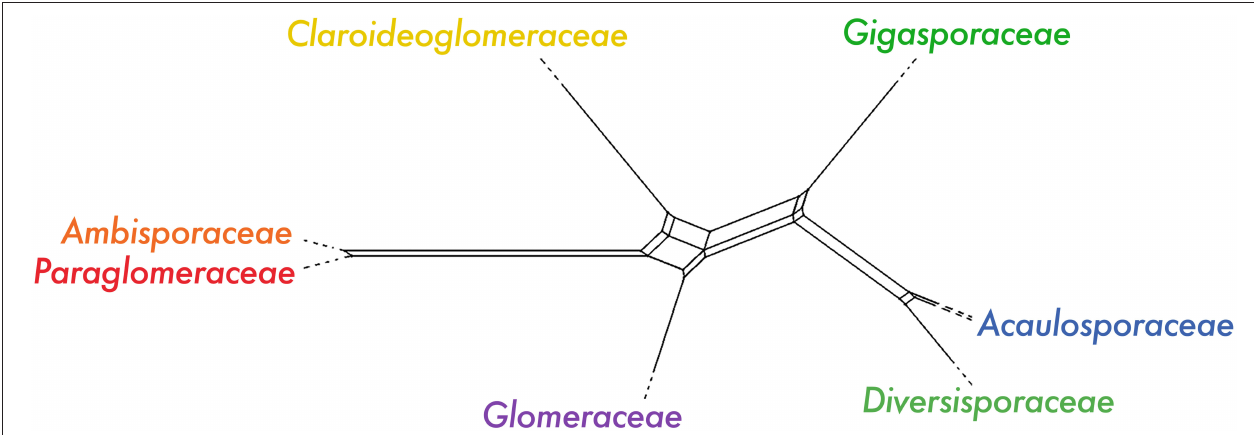
FIGURE 3 | IQ-TREE network analysis visualized in SplitsTree5 with maximum dimension splits filter of 2, using the dataset containing all Glomeromycota taxa, and 1,737 SCOs shared among > 50% of the taxa. See Supplementary Figure 13 for expanded network with full branch